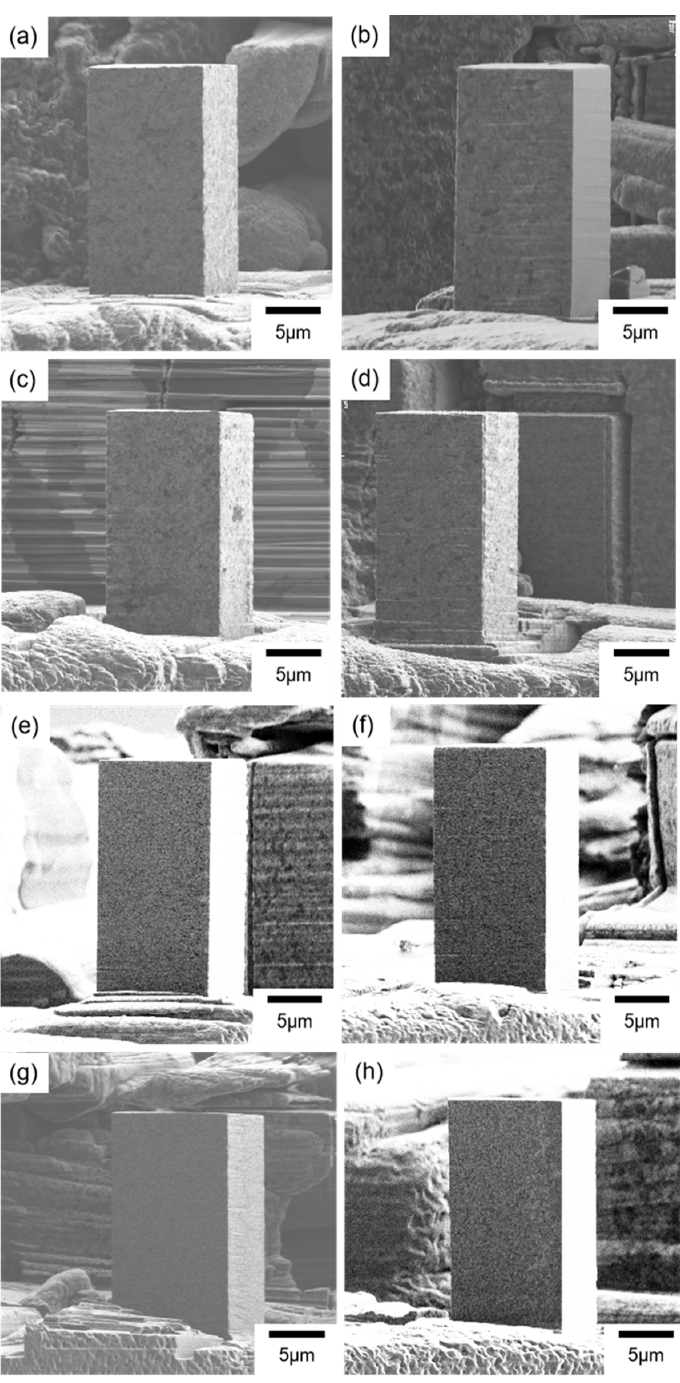
Figure 4. SIM images of the micro-pillars fabricated from the nickel–cobalt alloys electrodeposited with the bath containing ( a – d ) nickel bromide, ( e ) the Surf-Bright, or ( f – h ) both nickel bromide and the Surf-Bright, and at a current density of ( a , f ) 12 mA/cm 2 , ( b , e , g ) 15 mA/cm 2 , ( c ) 18 mA/cm 2 and ( d , h ) 20 mA/cm 2 .